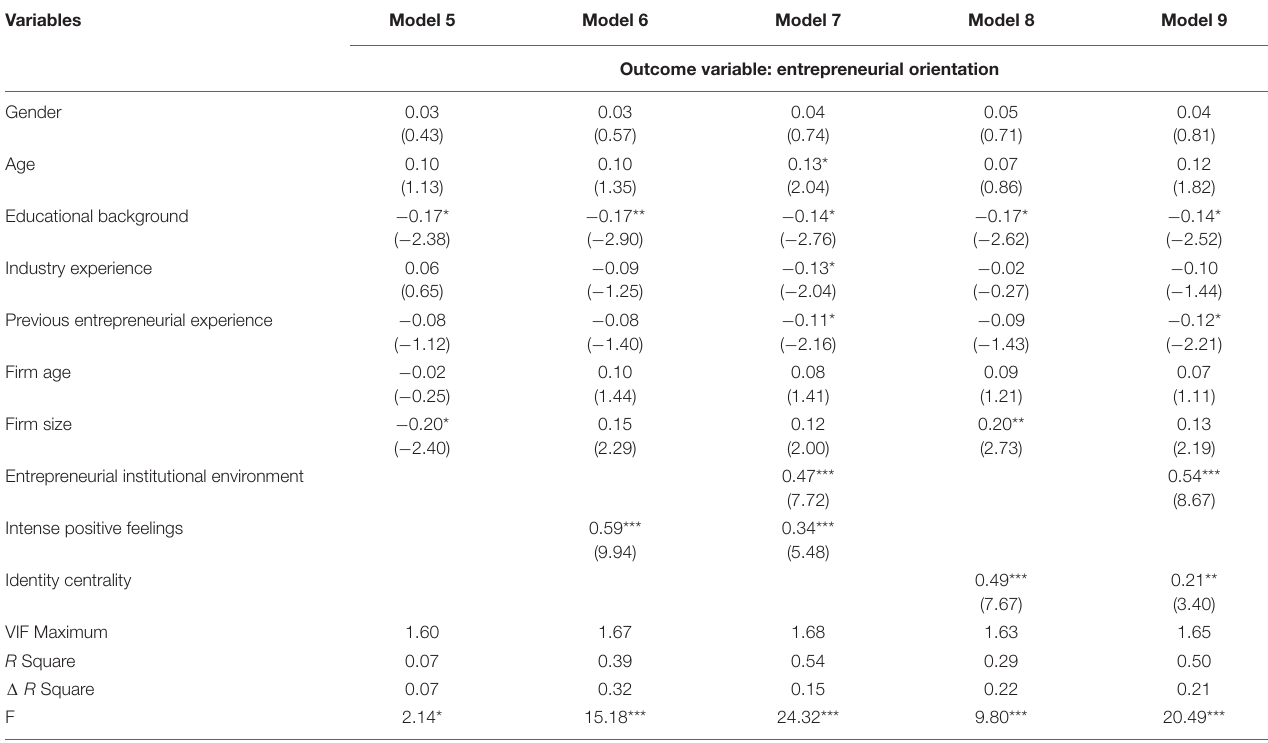
TABLE 6 | Regression analysis of mediation